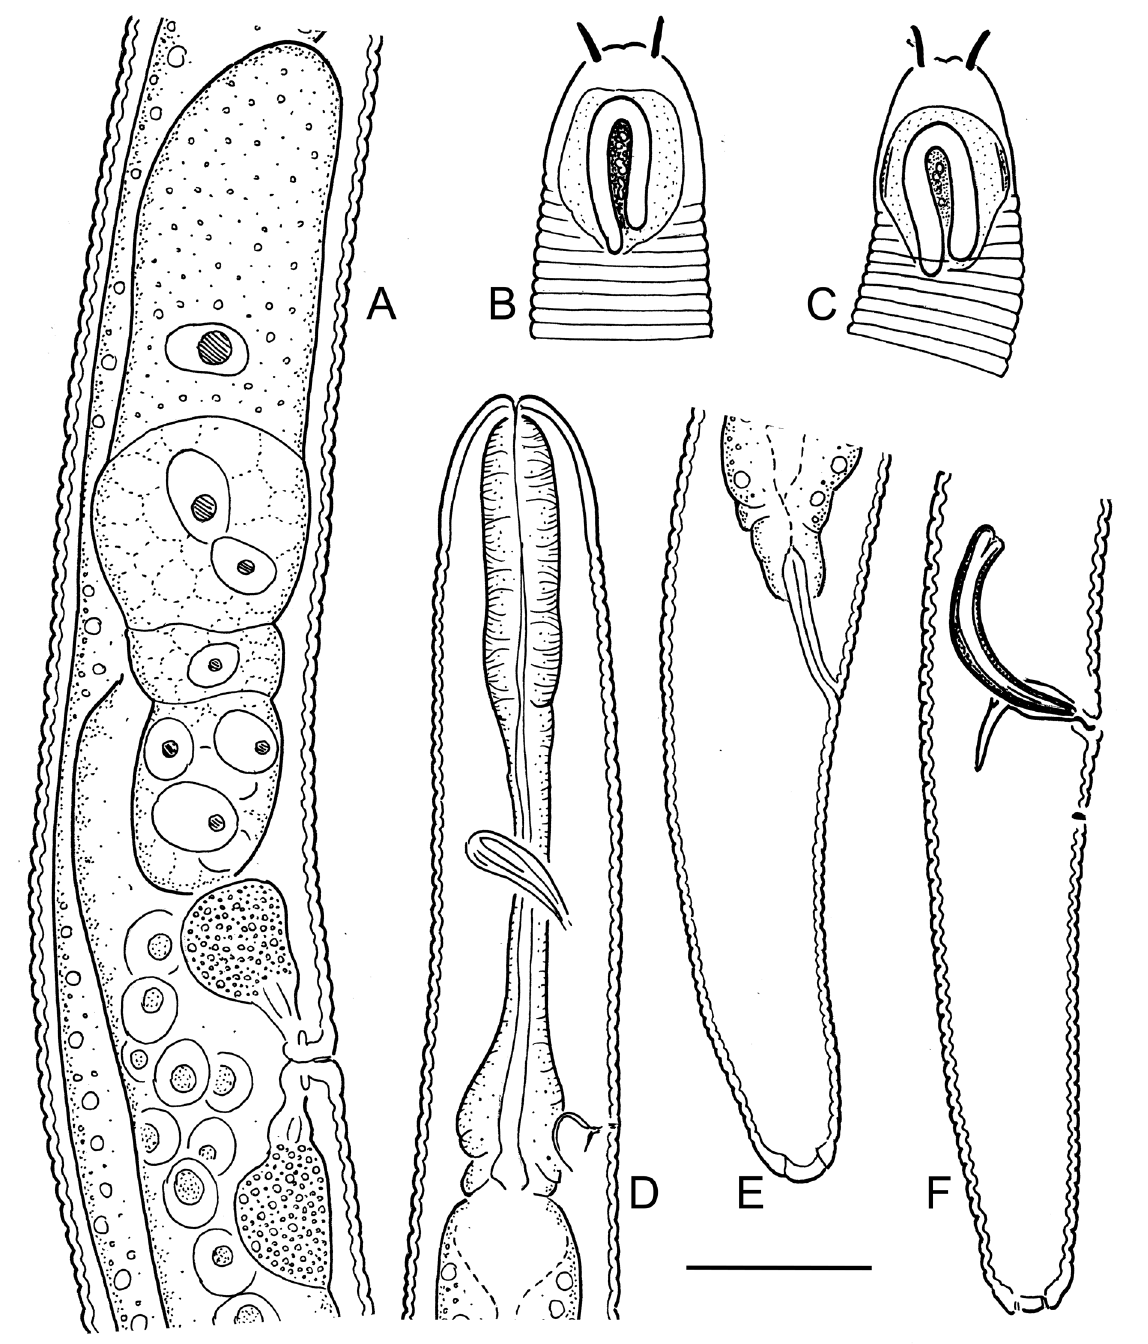
Fig. 1. Diplopeltoides suecicus sp. nov. A . Anterior part of the female reproductive system. B . Female anterior end, surface view. C . Male anterior end, surface view. D . Female pharyngeal region, optical median section. E . Female tail. F . Male tail. Scale bar = 20